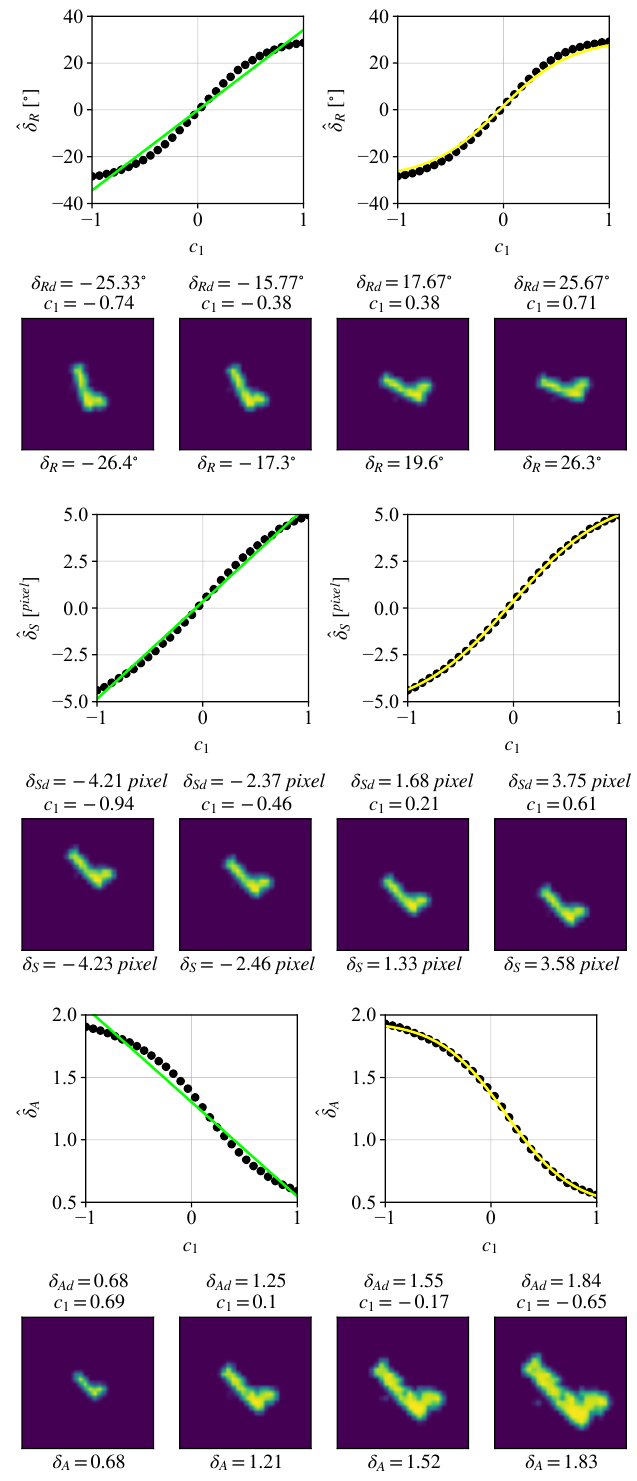
Figure 8. The results for the measured and modeled rotation ( top ), translation ( middle ), and scaling ( bottom ) for the SAR images synthesized by the InfoGAN trained with the second dataset. In each case, we show the relation between c 1 and the considered property (dots), approximations using linear (green line in left subplots) and nonlinear models (yellow line in right subplots), and synthesized SAR images using c 1 calculated by (26) for four desired δ Rd , δ Sd , and δ Ad . The estimated properties of the synthesized SAR images, δ R , δ S , and δ A , are measured by (19). They are close to the desired